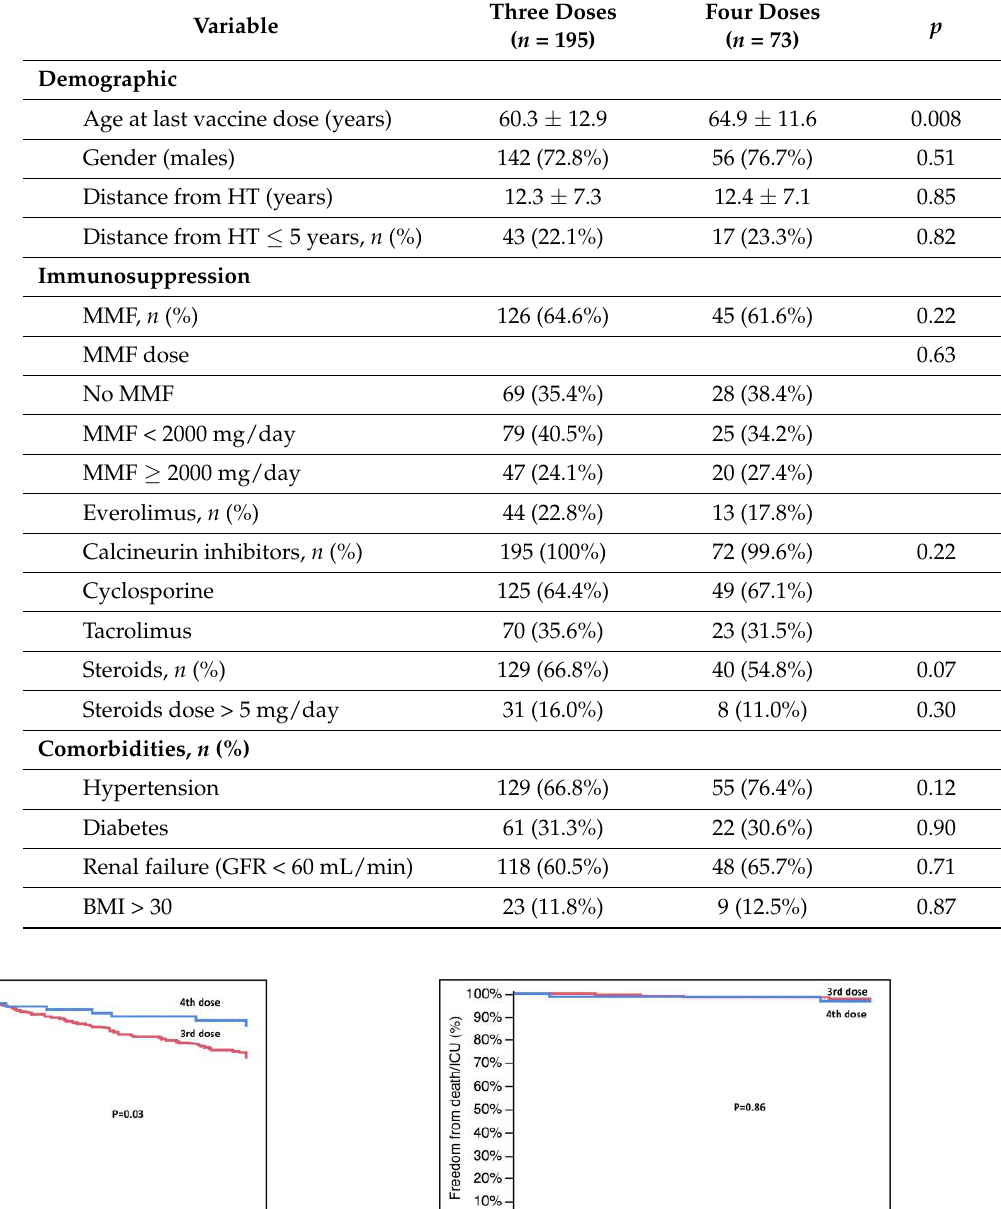
Table 2. Characteristics of the individuals receiving three vs. four doses of vaccine.